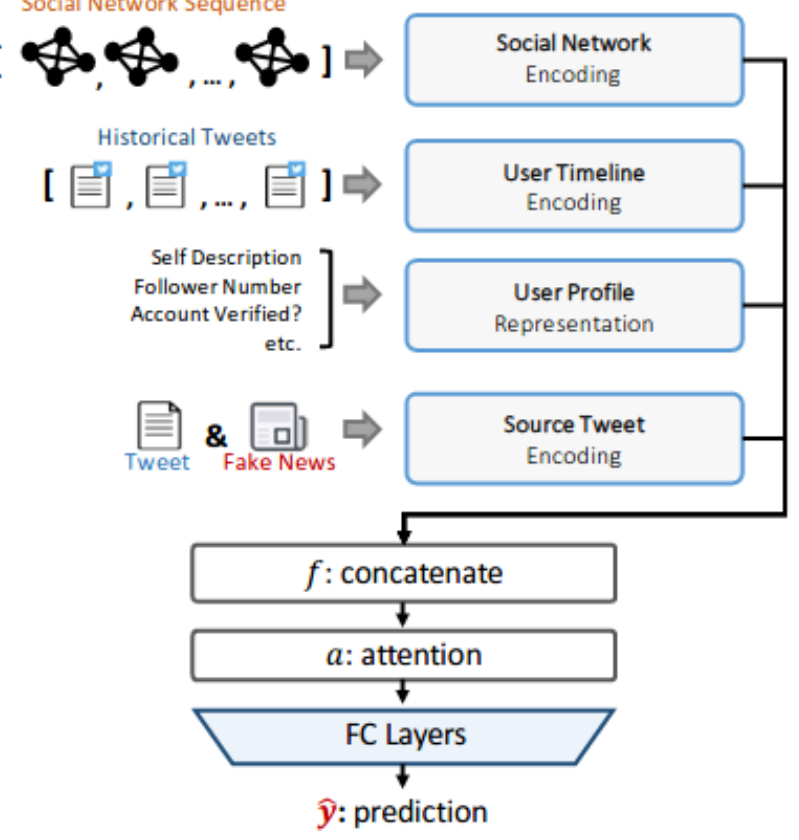
Figure 3. The architecture of our MUFFLE